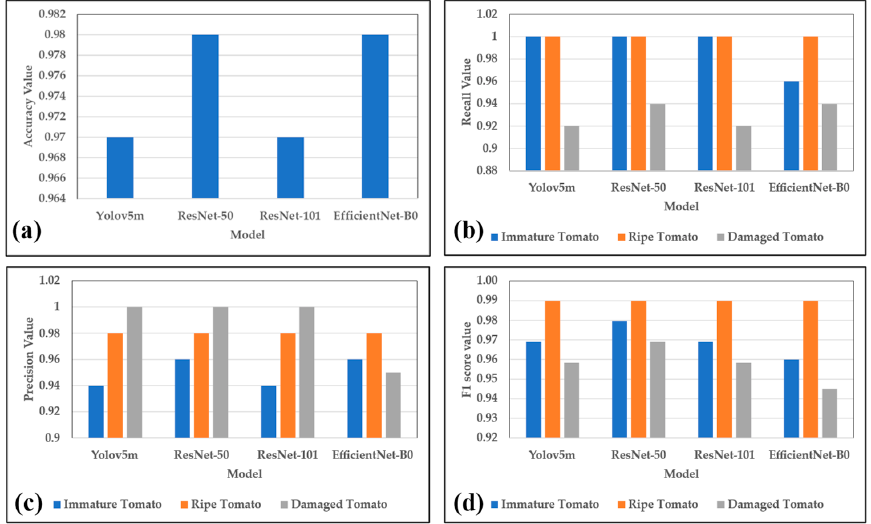
Figure 3. Accuracy, recall, precision, and F1 scores of the four models. ( a ) Accuracy, ( b ) recall, ( c ) precision, and ( d ) F1 score.